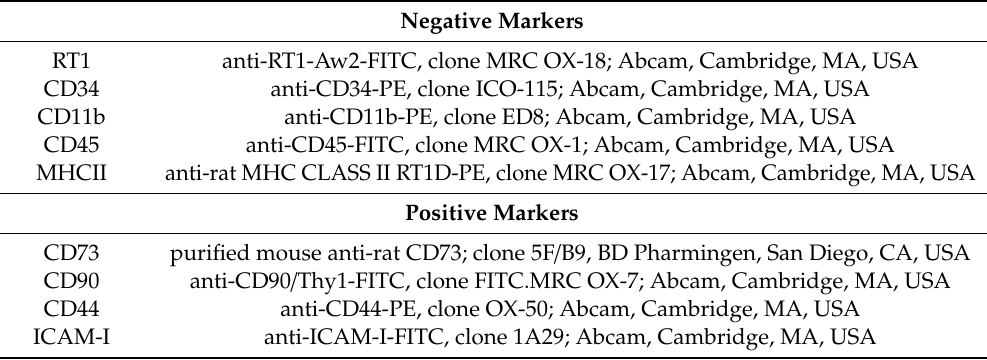
Table 1. Surface markers for mesenchymal stem cells (MSCs)